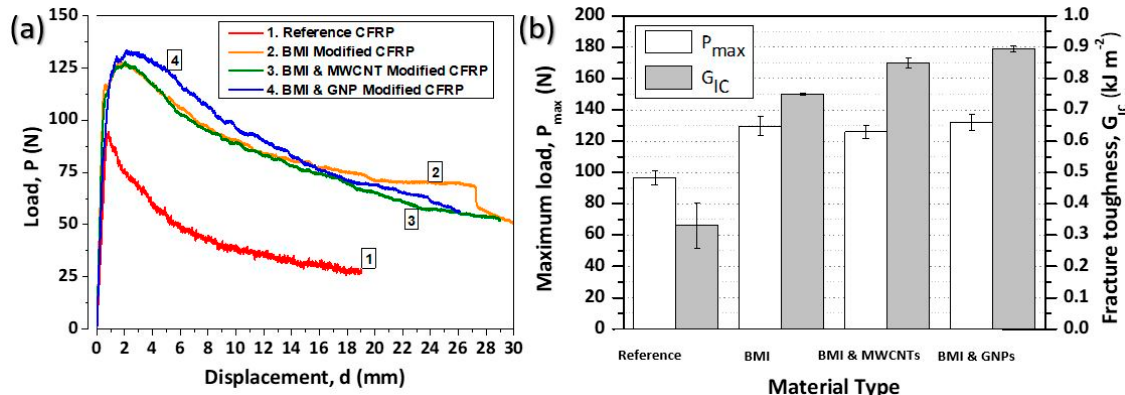
Figure 5. ( a ) Typical load (P) versus displacement (d) curves for the reference and modified CFRPs with pure BMI, BMI and MWCNTs and BMI and GNPs. ( b ) Bar chart diagram containing the synopsis of Mode I testing results in terms of peak load (P max ) and fracture toughness energy I (G IC ) values.